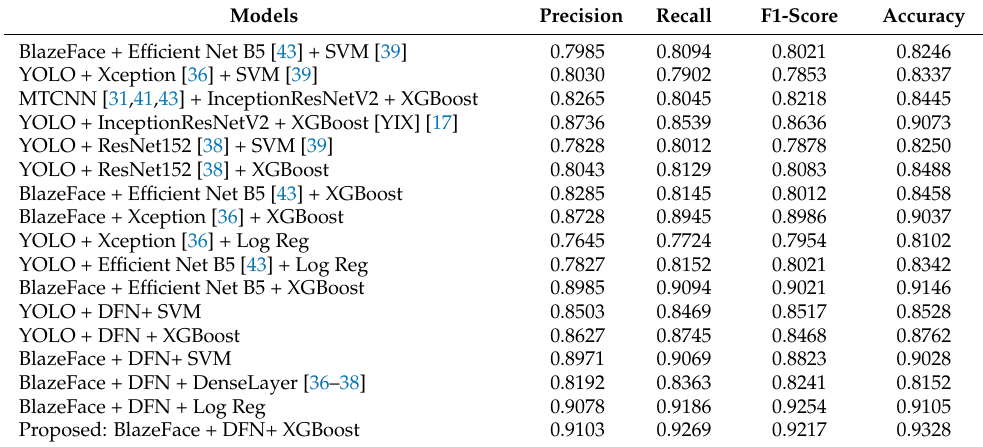
Table 8. Performance Comparison of Proposed Method with Other Methods Using the DFDC Dataset. Models Precision Recall F1-Score